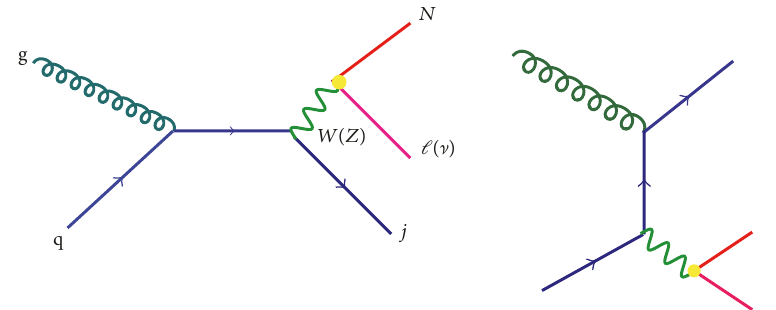
Figure 4: 1-jet process to produce 𝑁 with ℓ( ] ) in association with a jet from the CC(NC) interaction from qg initial